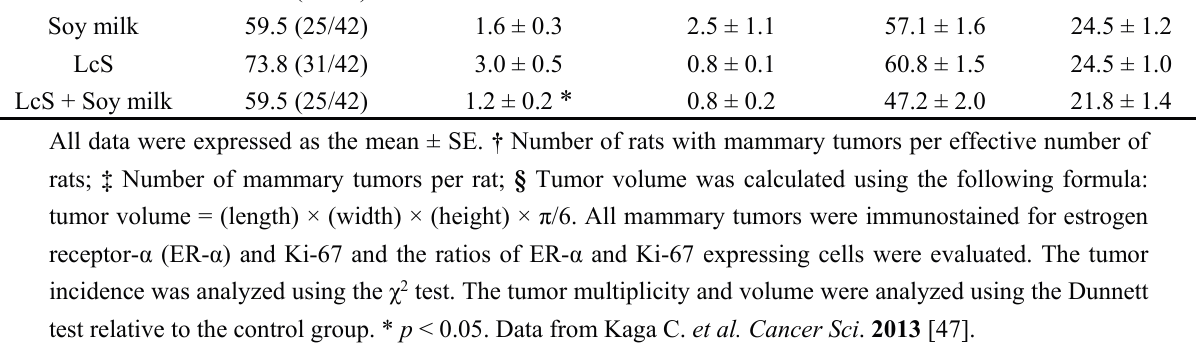
Tumor Tissue Profile Multiplicity Volume (tumors/rat) ‡ (cm 3 /tumor) §